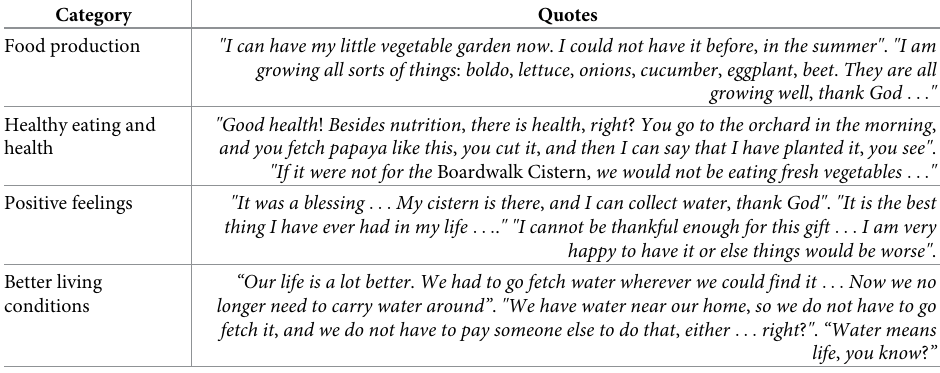
Table 4. Families’ perception of what has changed in their lives in recent years and how cisterns have facilitated their lives in the semi-arid region of Alagoas, Brazil, 2016. Category